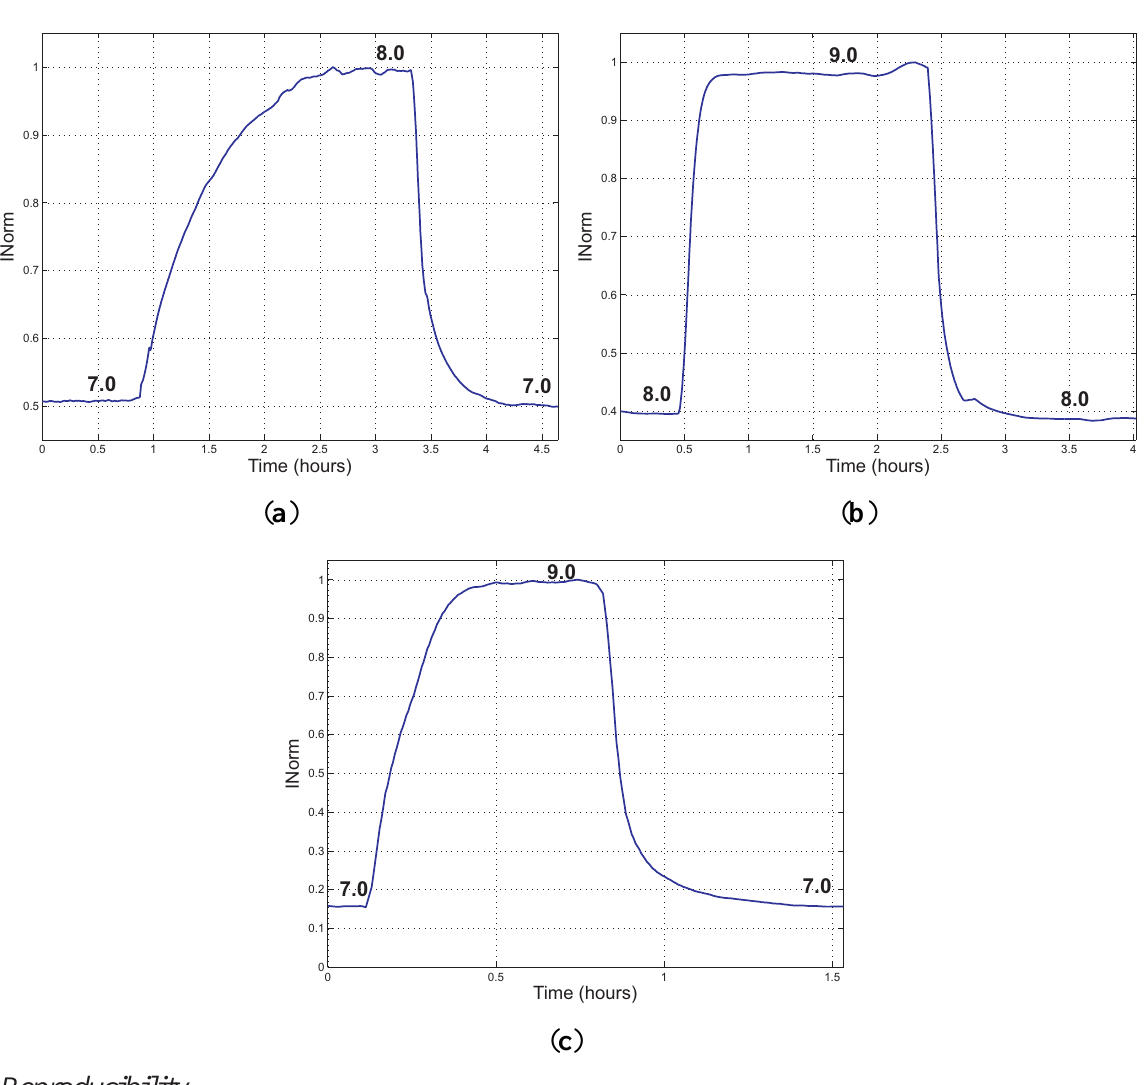
Figure 13. I versus time acquired during the three tests performed to evaluate the Norm response time of the sensor and its dependency on the pH value. ( a ) Sensor response to a change in pH from 7 to 8 and back; ( b ) sensor response to a change in pH from 8 to 9 and back; ( c ) sensor response to a change in pH from 7 to 9 and